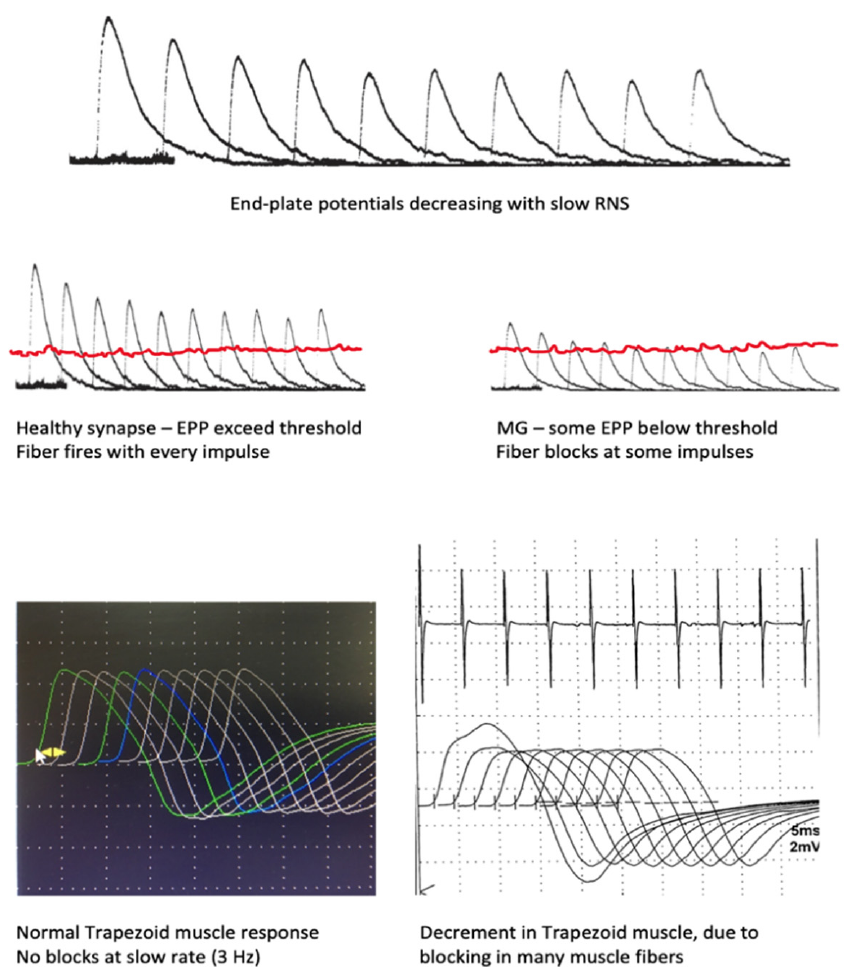
Figure 2. Synaptic events leading to blocking in single muscle fibers and decrement of the compound muscle action potential (CMAP).